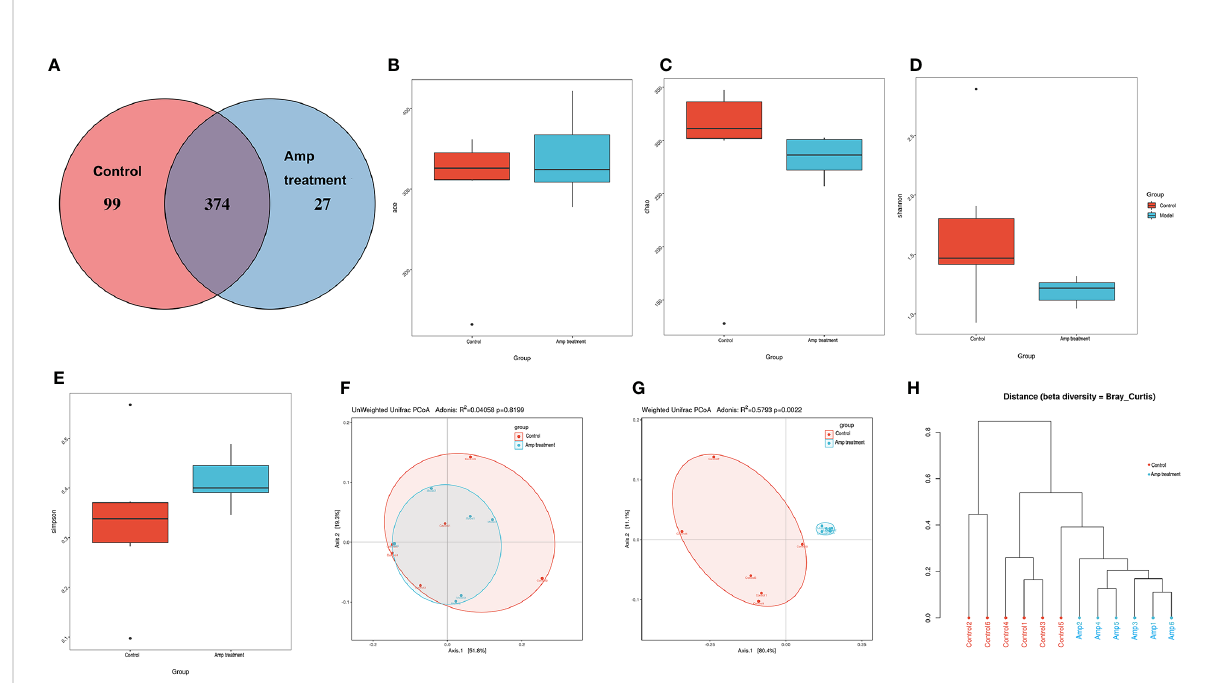
FIGURE 5 Effect of ampicillin on intestinal micro fl ora diversity in renal transplantation mice. (A) OTU Venn diagram. Each note represents a group (n=6), and the number of the overlapping part between the color graphs refers to the total number of OTUs between the two groups, while the non- overlapping part refers to the number of OTUs unique to each group. (B-E) Difference analysis of alpha diversity index between the two groups. (B) ace, P-value: 0.8182. (C) chao, P-value: 0.132. (D) Shannon, P-value: 0.132. (E) simpson, P-value: 0.065. (F, G) Difference analysis of beta diversity index between the two groups using principal coordinate analysis (PCoA). PCoA plots using weighted-UniFrac metric and unweighted- UniFrac metric. (H) Tree view of similarity of multiple